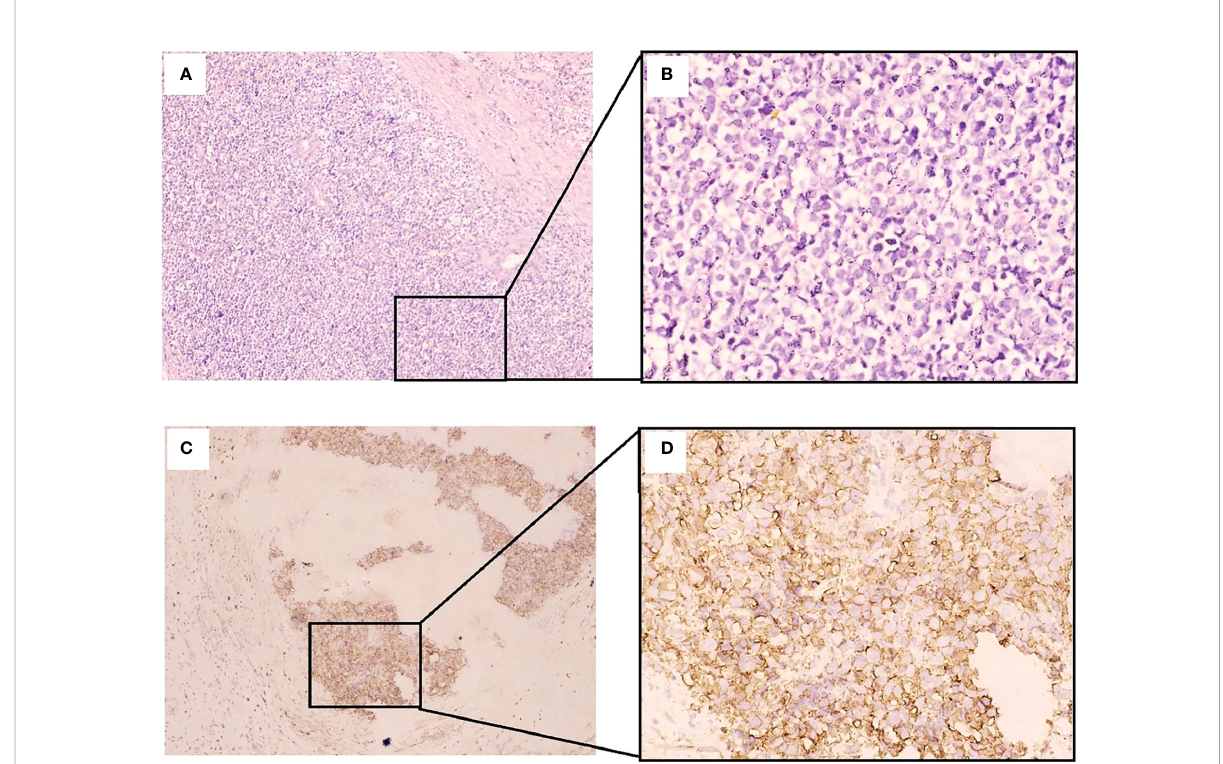
FIGURE 4 Histological and immunohistochemical features of the tumor of sphenoid sinus. (A, B) Hematoxylin and eosin (H & E) staining of a tumor specimen showing small round atypical cells with densely stained chromatin and high nuclear cytoplasmic ratios. (B, C) Immunohistochemical staining of a tumor specimen showing diffuse positive staining for CD99 on the tumor cell membrane. (A, C) : Original magni fi cation × 100; B, D : Original magni fi cation ×